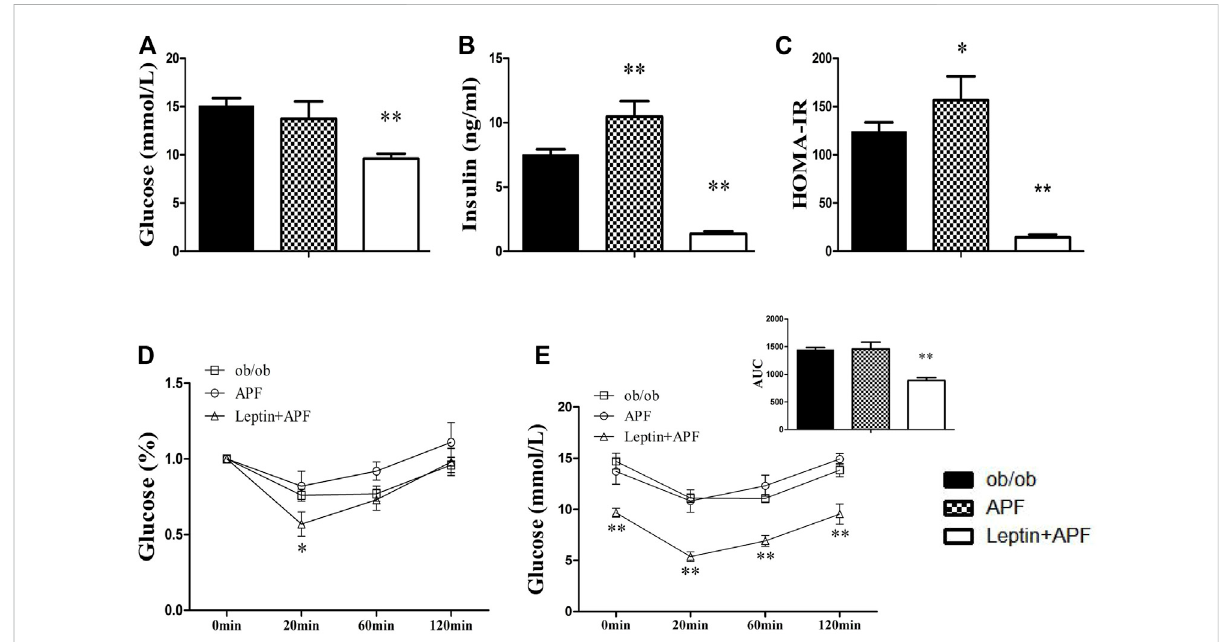
Effects of APF and supplementary Leptin on insulin resistance in ob/ob mice. Fasting plasma glucose (A) , insulin (B) , homeostatic model assessment of insulin resistance (C) , intraperitoneal insulin tolerance test (D) and area under the curve of kinetics pro fi les (E) after 1 U/kg intraperitoneal injected insulin administration of ob/ob group (black bars), APF group (grid bars) and APF + leptin group (white bars) after treatment with APF 15 weeks or APF + lepin 2 weeks. Values are means ± SEMs, n = 6-8 per group. * p < 0.05, ** p < 0.01 versus ob/ob group.